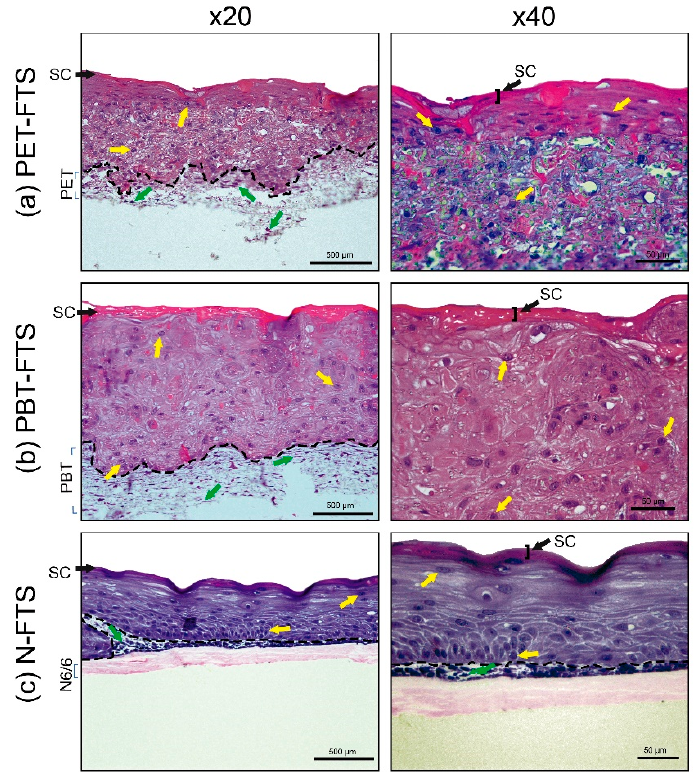
Figure 2. Fibroblasts (shown by green arrows) and keratinocytes (shown by yellow arrows) seeded on ( a ) PET, ( b ) PBT, and ( c ) N 6/6 scaffolds. The histology of the polymers-full-thickness skin (FTS) shows a quite delimited dermis and epidermis (shown by black dotted lines). SC: Stratum corneum (shown by black arrows). Magnification = 20×, bar = 500 μ m. Magnification 40×, bar = 50 μ m.